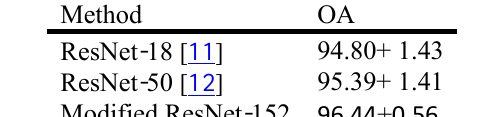
Table 4. Comparison with other ResNet variants